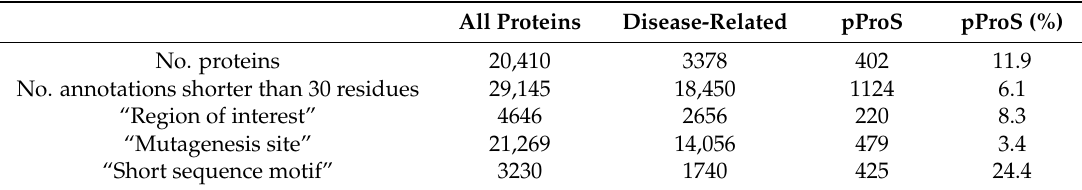
Table 1. Statistics of the UniProt